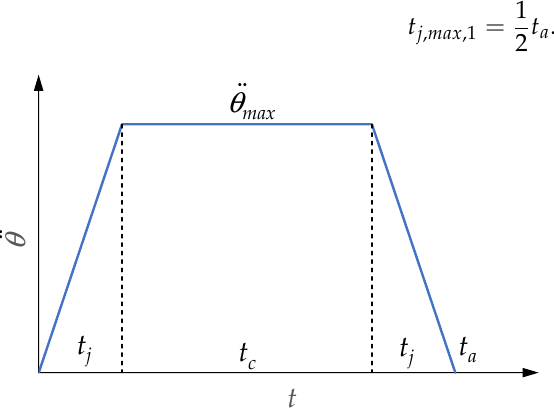
Figure 2. Symmetrical trapezoidal acceleration profile.